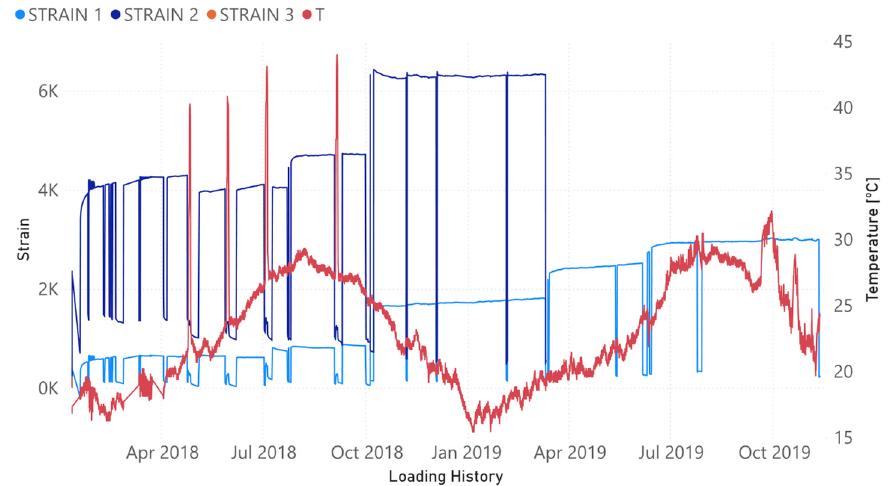
Figure 3. Evolution of strain/temperature along the loading history.